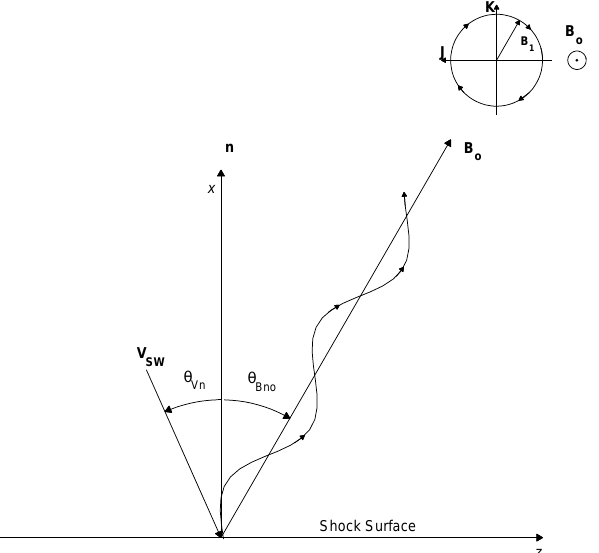
Fig. 4. A simple sketch showing the transverse wave upstream prop- agation from the shock and along the ambient magenetic